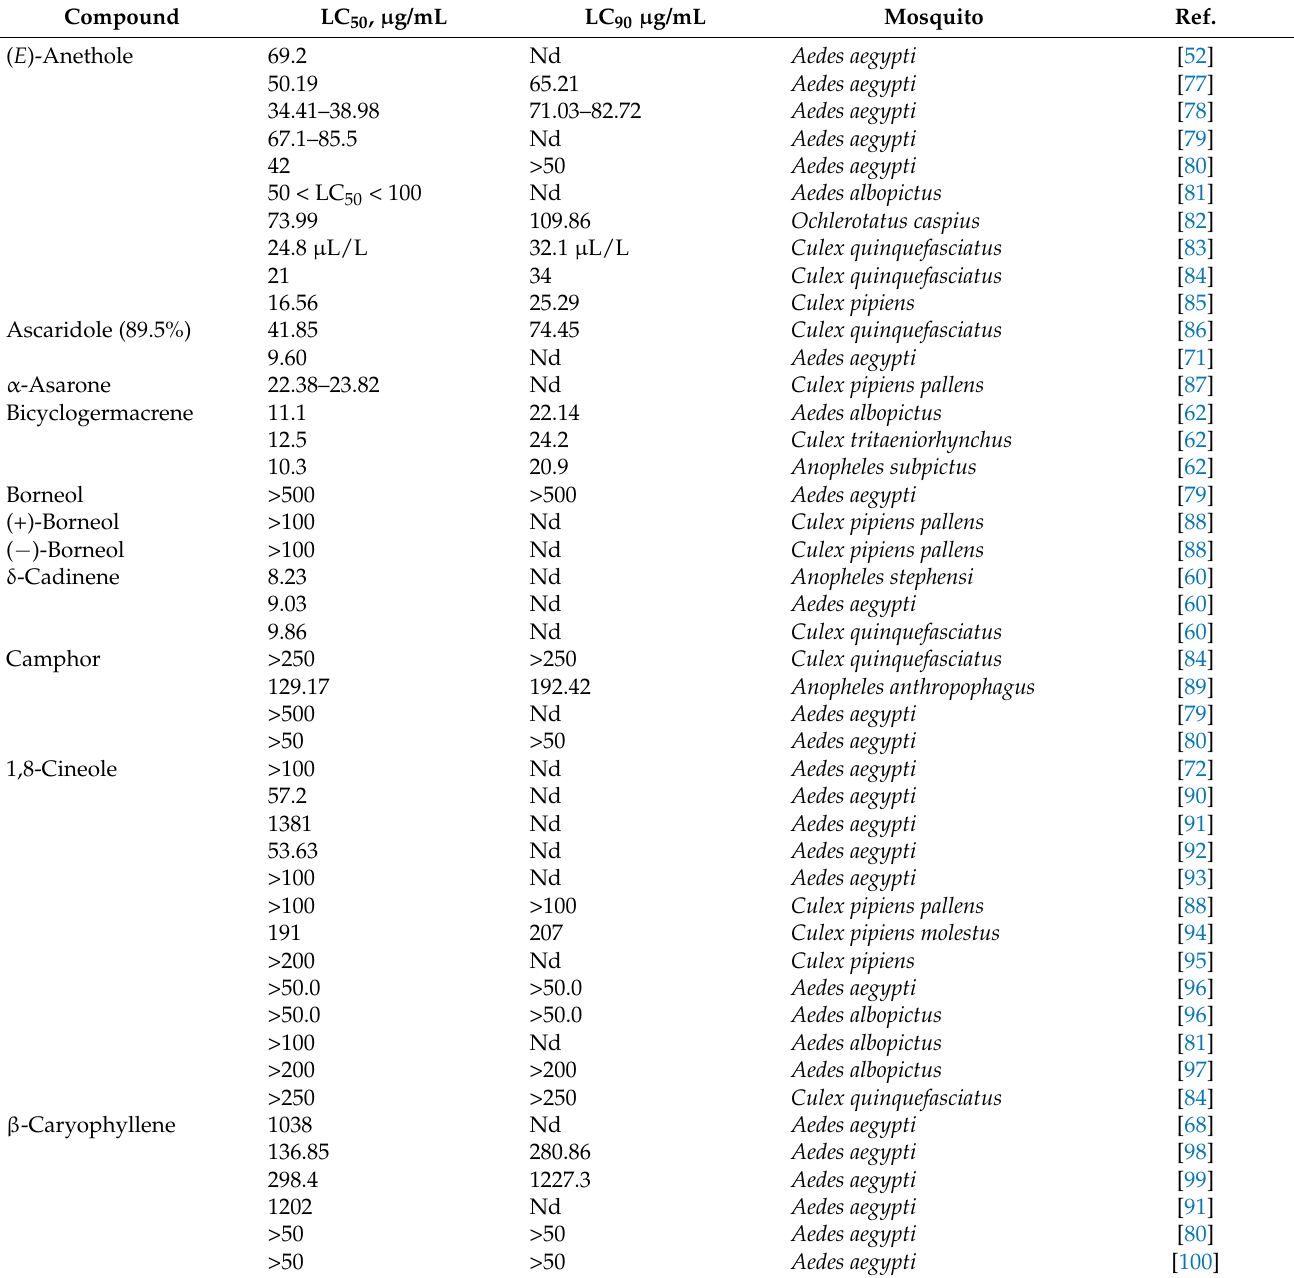
Table 5. Summary of mosquito larvicidal activity of main components in Croton spp. essential oils (24 h or 48 h